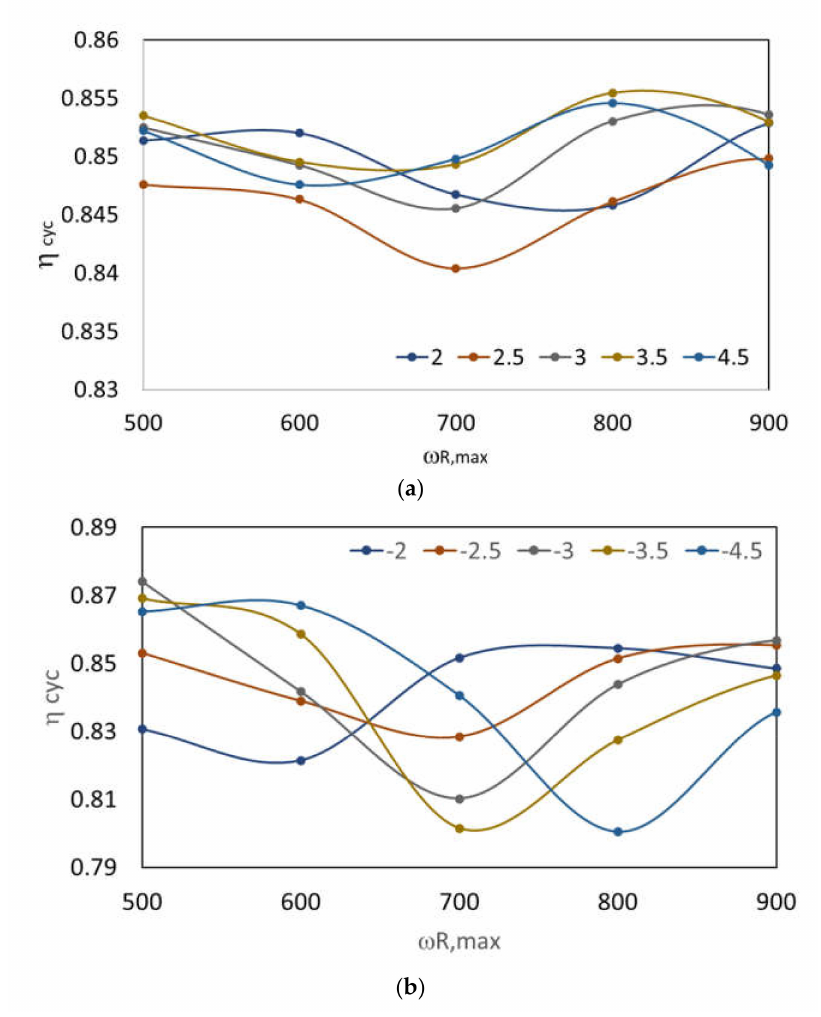
Figure 9. Average efficiency over the Artemis DC by varying ρ and ω maxR : ( a ) single-planet gear; ( b ) double-planet